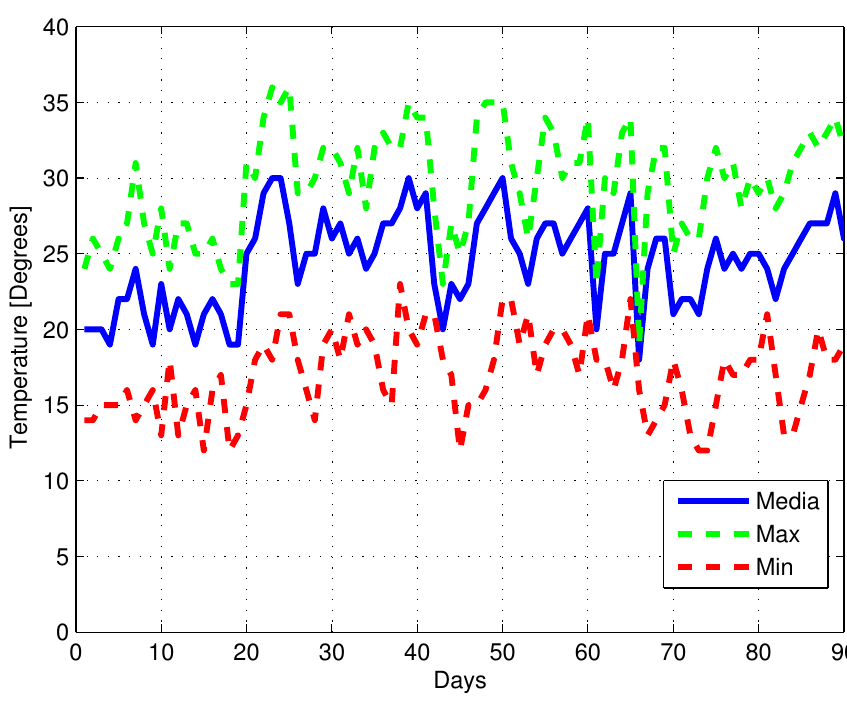
Figure 9. Three-month temperature measurement campaign